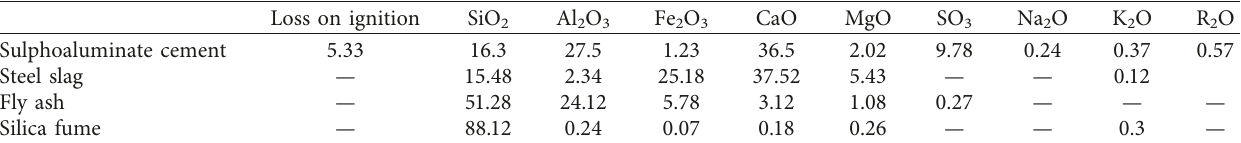
Table 2: Chemical compositions (%) of cement and mineral admixtures.